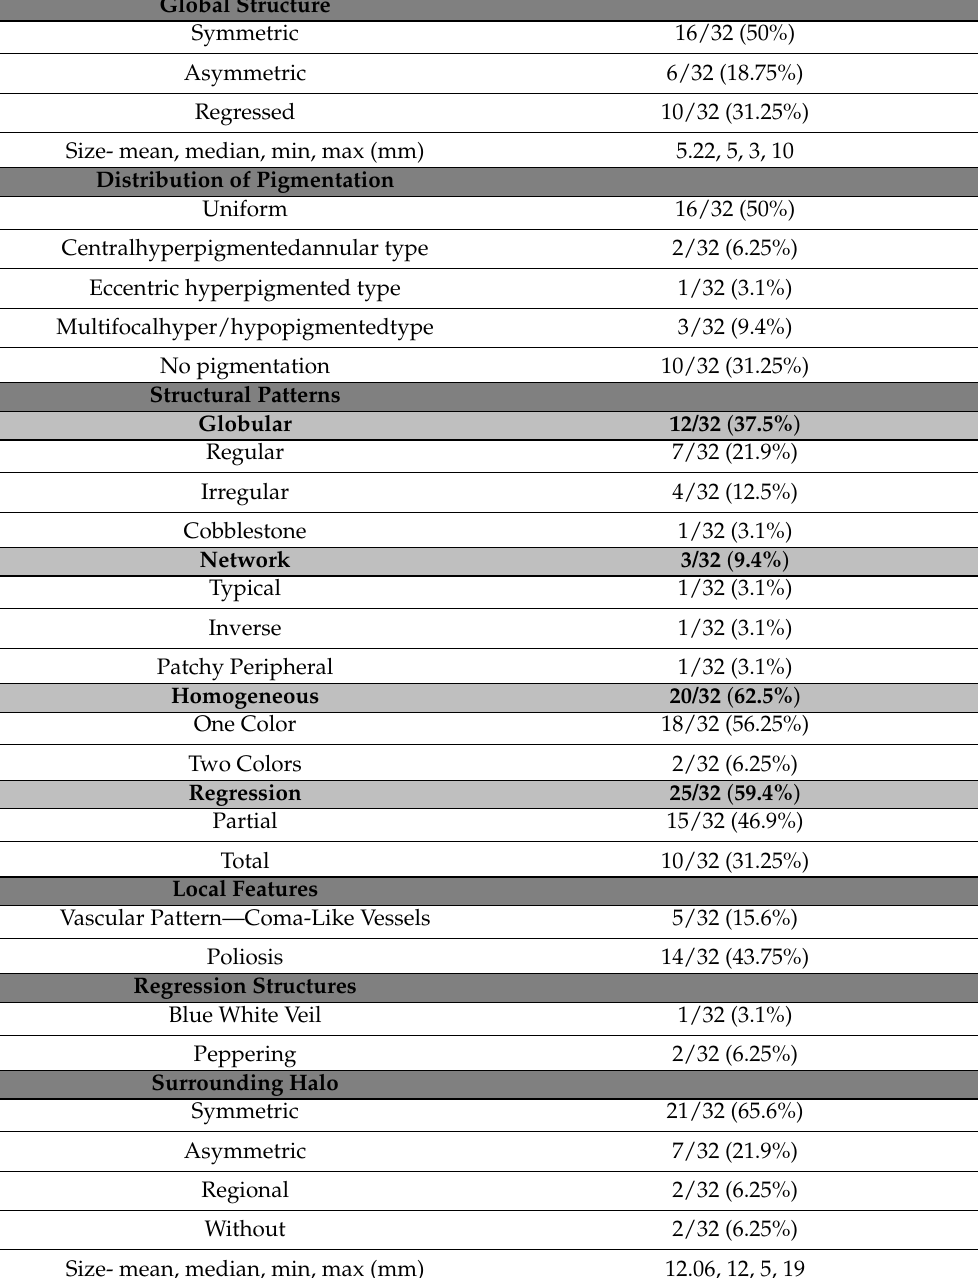
Table 1. Dermoscopic features of our investigated patient group with Sutton